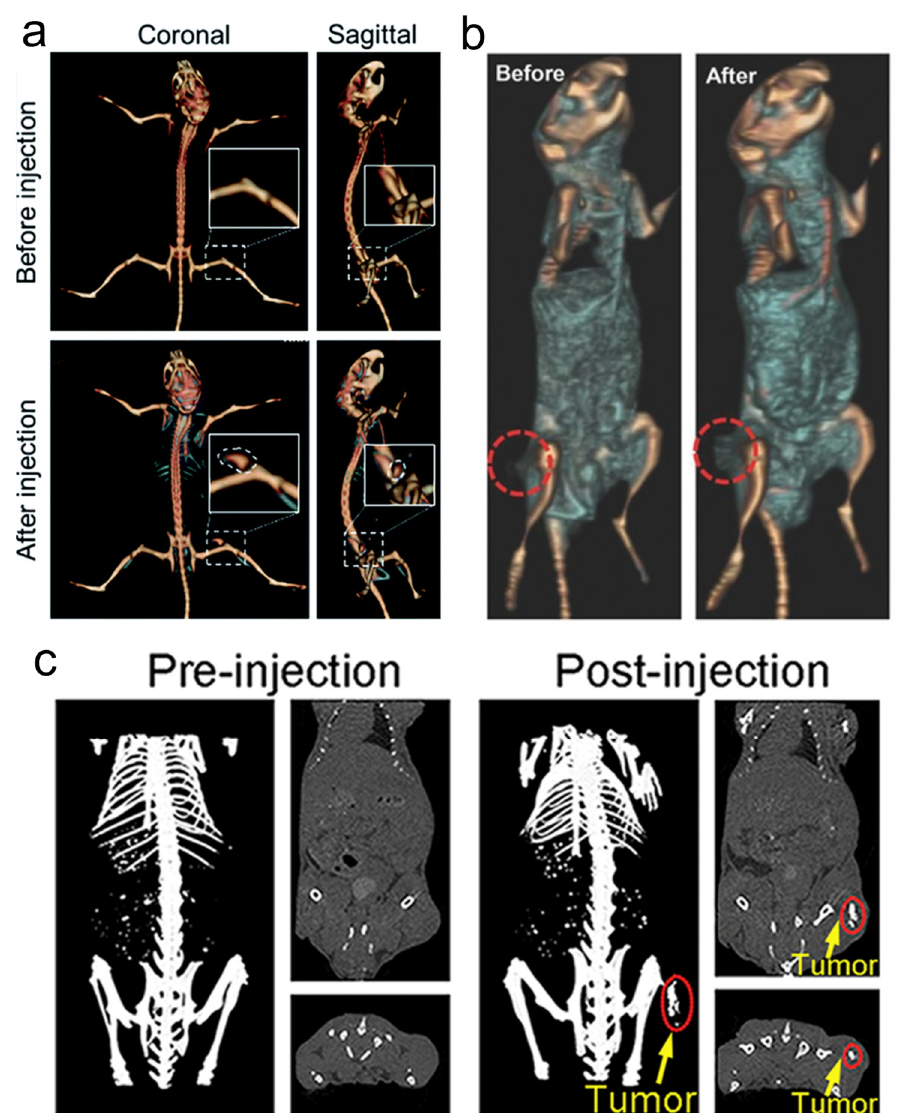
Figure 10. ( a ) CT imaging in vivo of 4T1 tumor-bearing BALB/c mice before and after injection